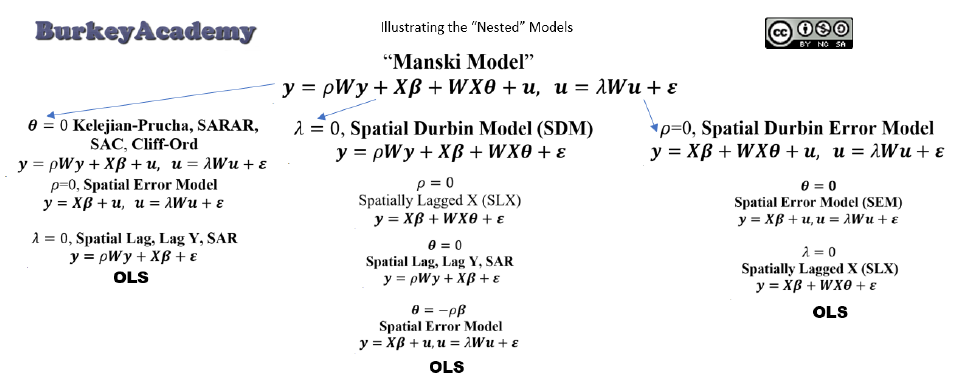
Figure 1: Part of the “Nested Models”